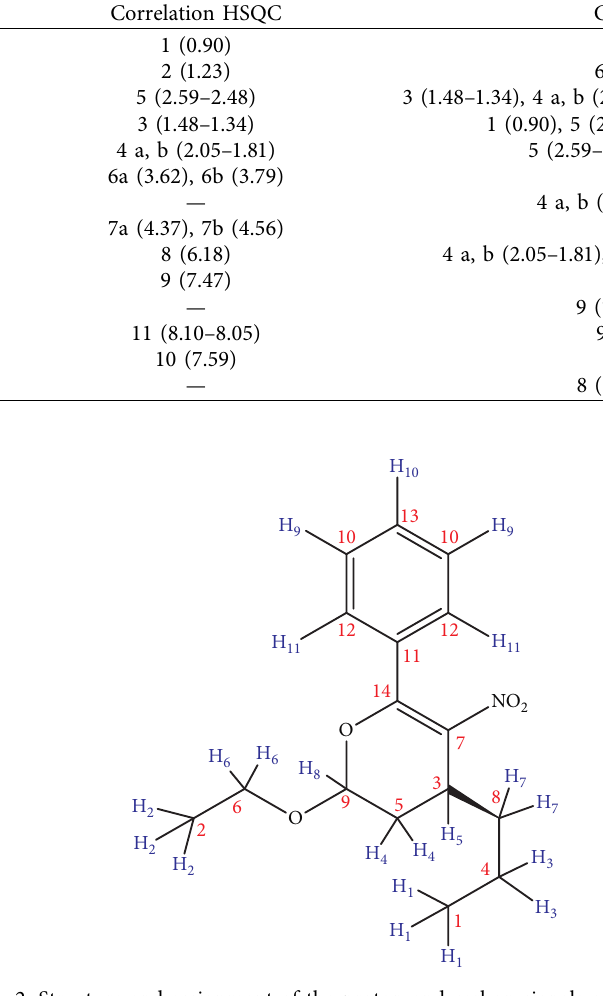
Figure 2: Structure and assignment of the proton and carbon signals of compound 3e .